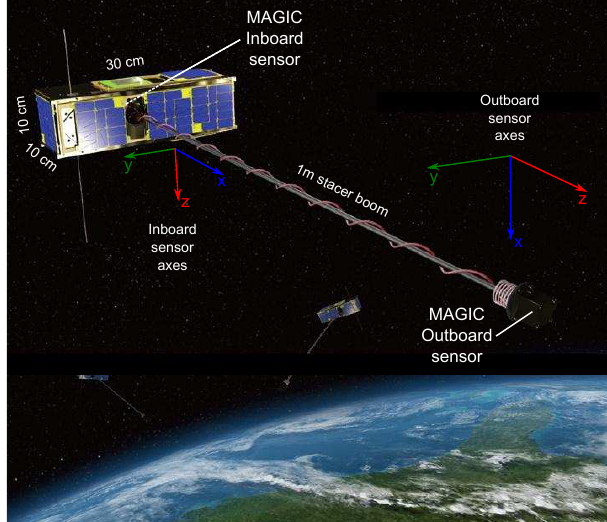
Figure 1. Schematic of CINEMA indicating the inboard (IB) and outboard (OB) MAGIC sensors and their respective axes. Image credit: CINEMA